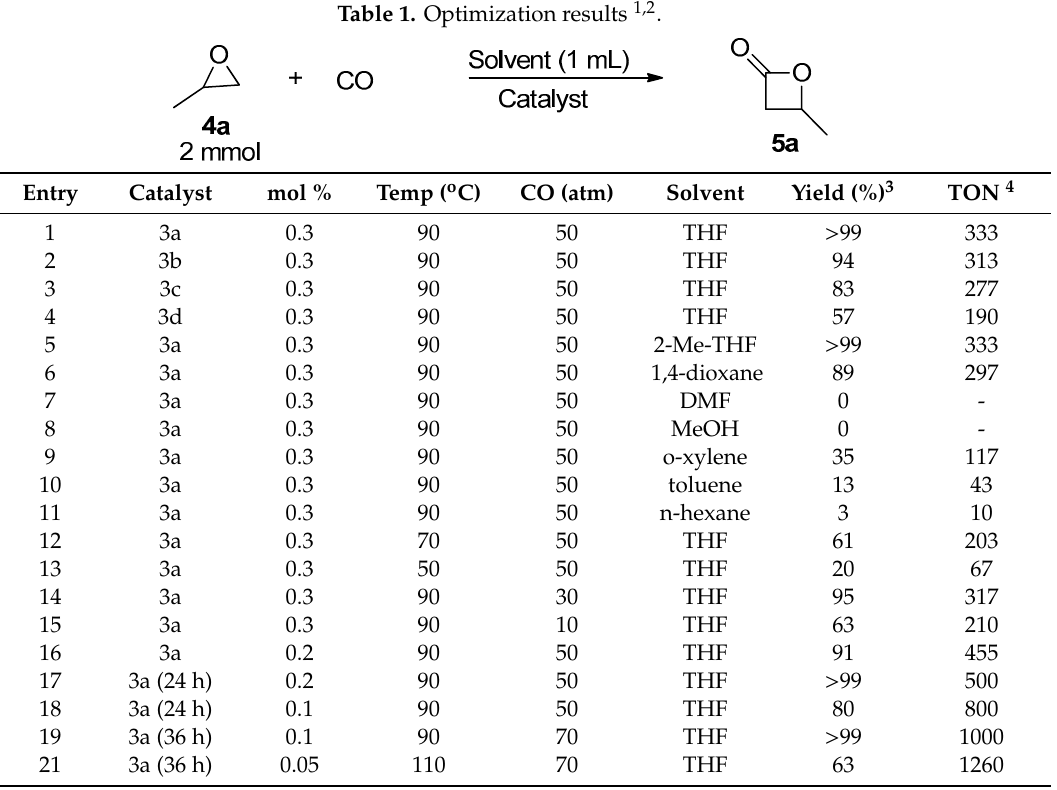
Table 2. Scope of substrates 1,2